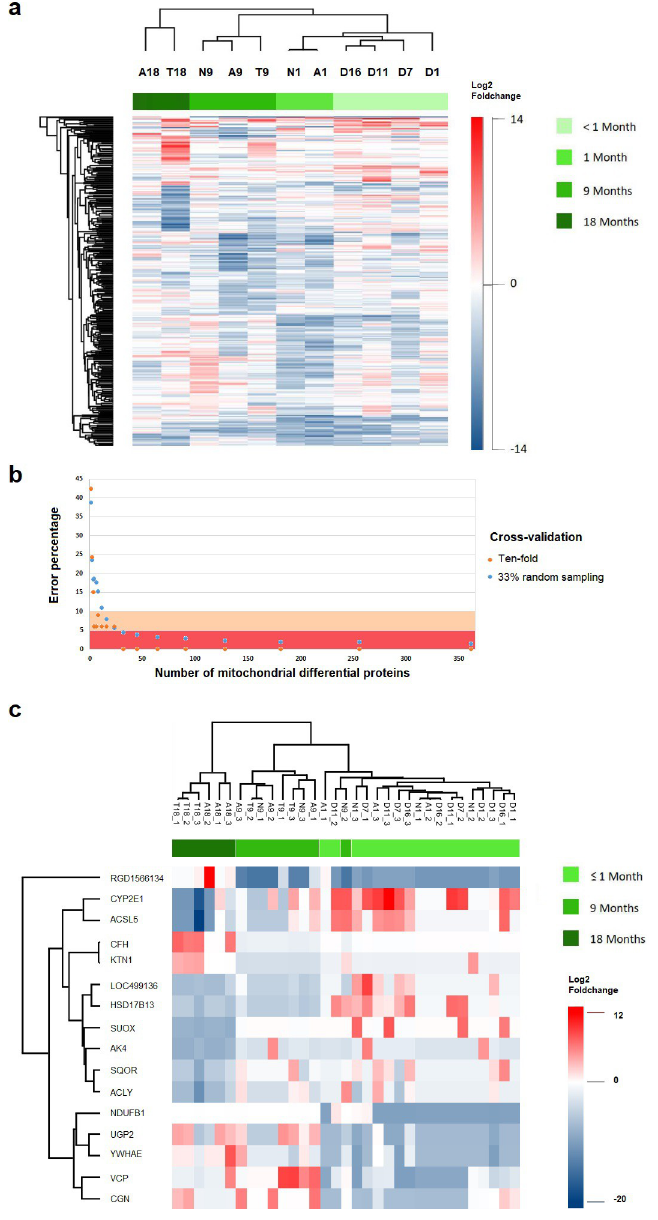
Fig 2. Proteomic expression profiles and its use for the models of samples classification according to stage of HCC development. ( a ) Pearson correlation-based hierarchical clustering using all differentially expressed proteins (N = 363); the stage of HCC development is shown in horizontal green scale on top. ( b ) Percentage of error of our models in classification of HCC development stage ( y -axis) in relation to the number of proteins used ( x -axis); pink area represents 10% of error and red area 5% of error; orange points represent ten-fold cross-validation and blue points 33% random sampling cross-validation, in both cases 250 repeats were used. ( c ) Independent classification of the HCC development stage of 33 samples (horizontal green scale on top) using the 16 disclosed proteins in our classification models.